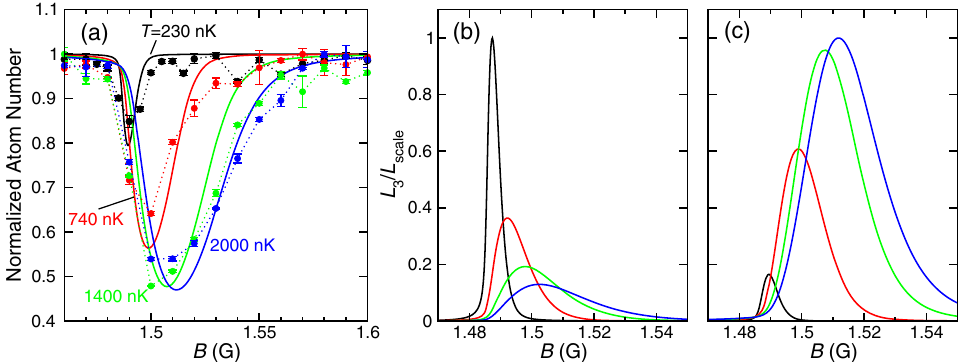
FIG. 7. Line shapes for a strongly temperature-dependent 168 Er Feshbach resonance near B ¼ 1 . 48 G. Panel (a) shows experimental data (markers with error bars) as a function of B of the remaining atom number divided by the atom number away from resonance measured 400 ms after initial preparation. Black, red, green, and blue markers correspond to data for temperatures T ¼ 230 , 740, 1400, and 2000 nK, respectively. Dashed lines connecting the markers guide the eye. Solid lines are theoretical line shapes of the remaining atom number based on the d -wave ( N ¼ 2 ) recombination rates shown in (c). Panels (b) and (c) show simulated three-body recombination rates for the same four temperatures assuming three-body entrance s - ( N ¼ 0 ) and d -wave ( N ¼ 2 ) scattering, respectively. Curves are based on a thermally averaged line shape discussed in the text. Recombination rates are scaled such that the 2 nK in (b) and 250 nK, while Γ ð E Þ =k 0 . 2 ð E=E =k largest value in each panel is one. For both panels, μ ¼ 3 . 1 μ and Γ B B ¼ B ¼ br ref Þ 4 nK in (c), where E 0 . 1 ð E=E 1000 Γ ð E Þ =k =k B ¼ B ¼ ref Þ ref